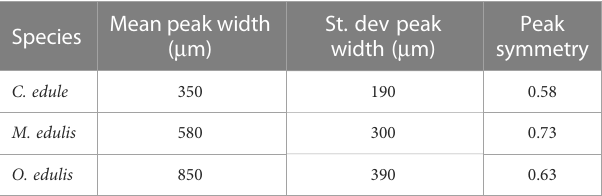
TABLE 3 Differences in width and shape of peaks between species. St. dev, standard deviation.